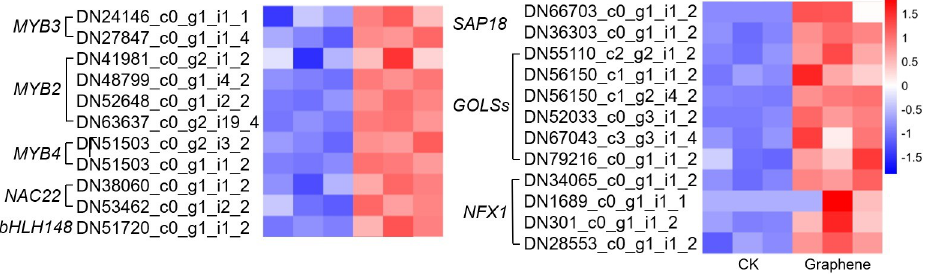
Fig 6. Selected candidate DEGs response to